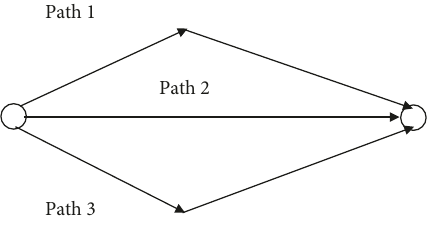
Figure 1: Robot motion path selection. Table 1: Average moving distance of CM and ICM compared through simulation.